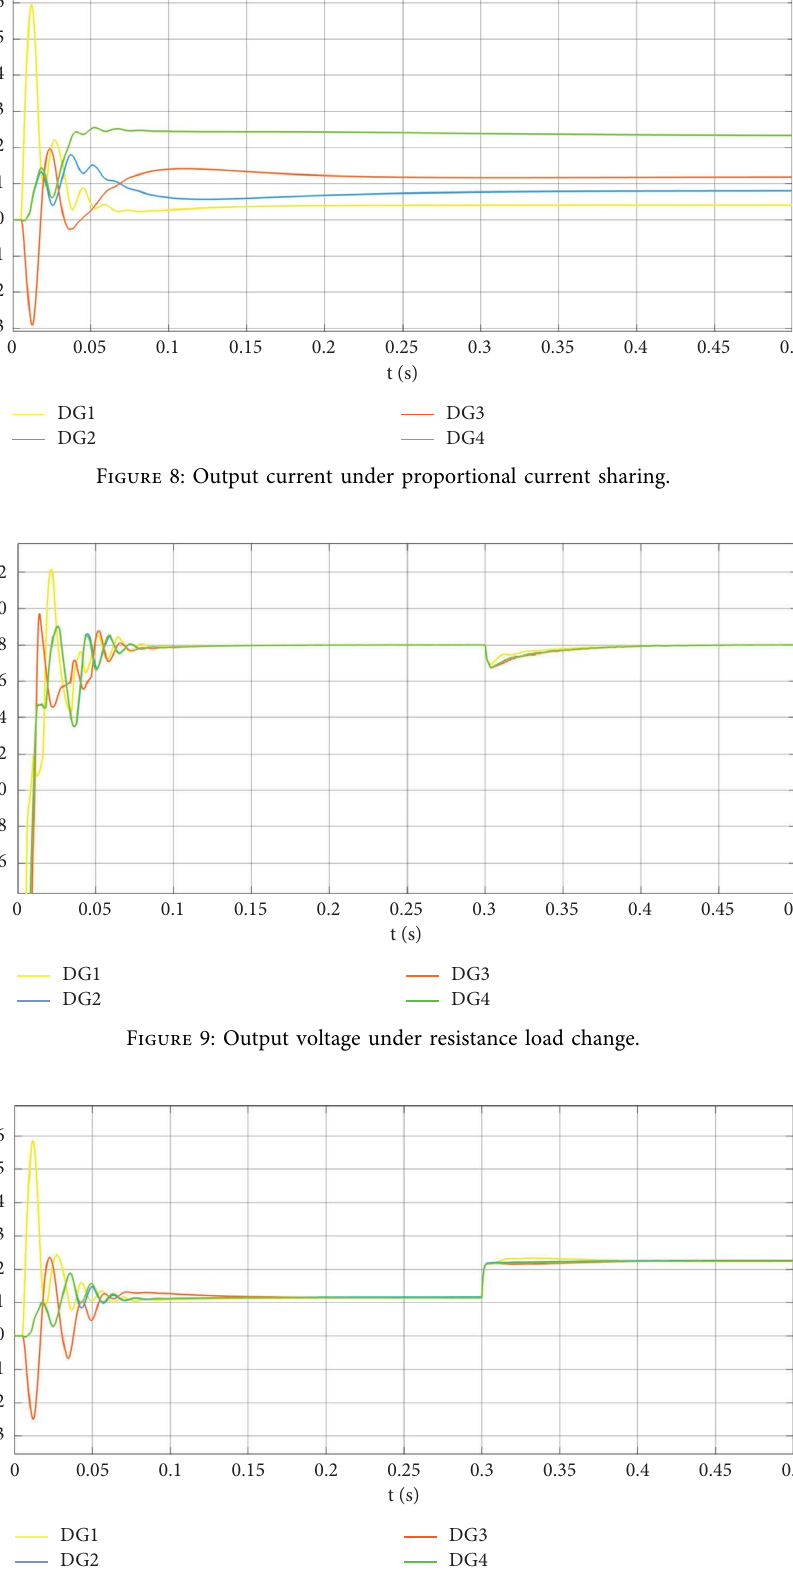
Figure 10: Output current under resistance load